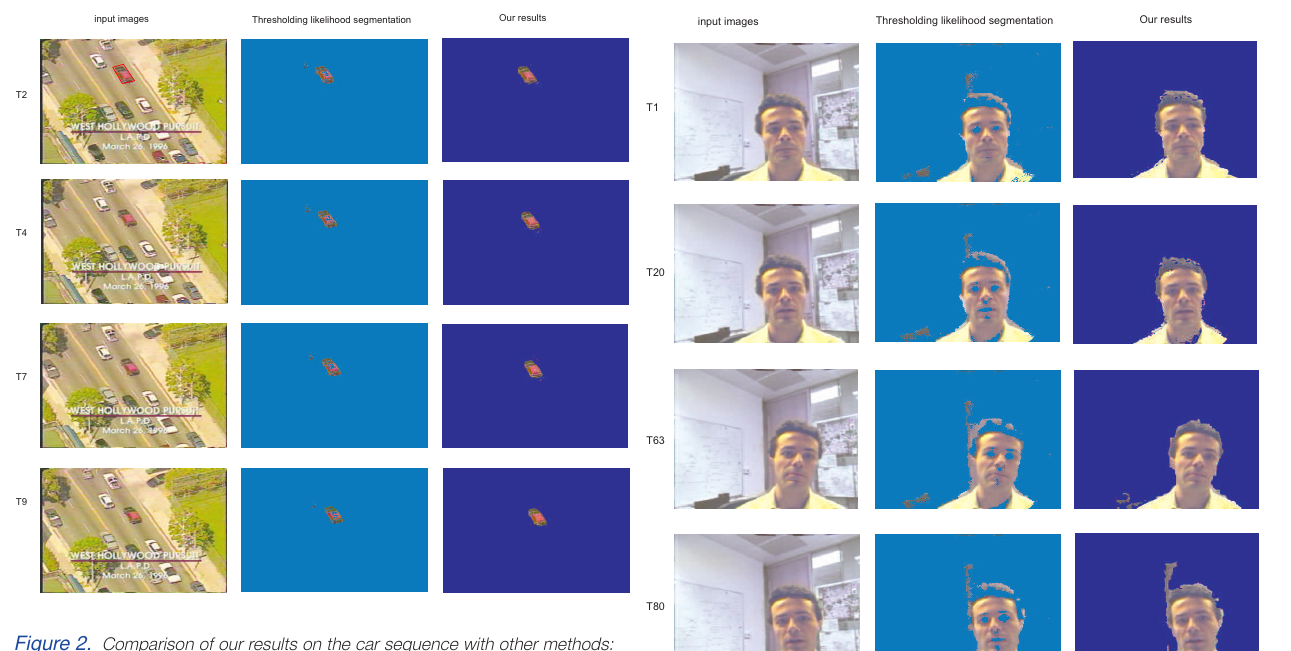
Figure 2. Comparison of our results on the car sequence with other methods: Left: input images; Middle: Results from segmentation of the manu- ally selected difference image. Right: Results from our algorithm. The camera is not stationary in the sequence.